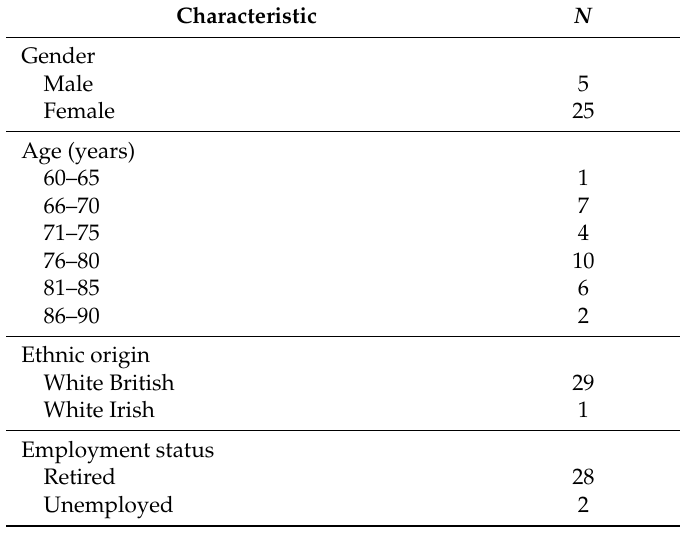
Table 1. Demographic characteristics of the participants in the focus-group